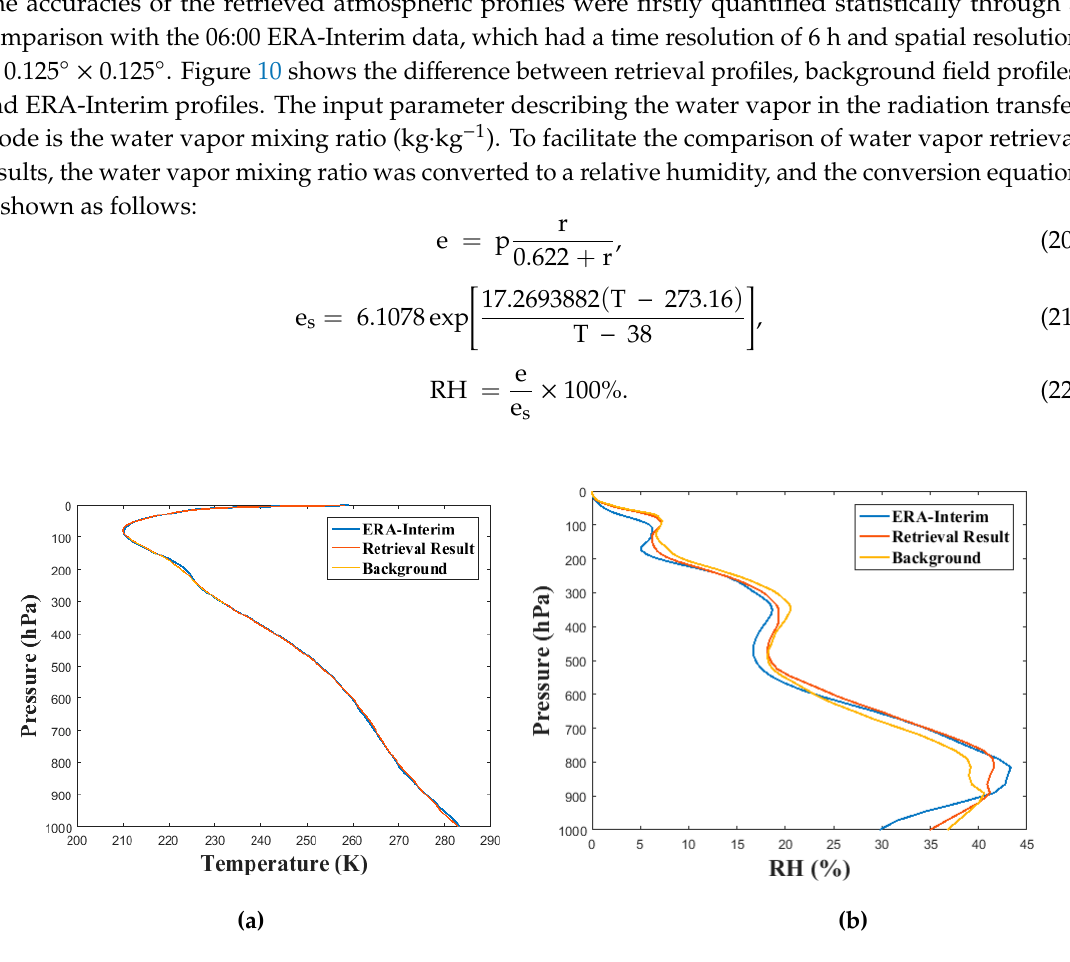
Figure 10. ( a ) Temperature and ( b ) humidity profiles based on 294 samples. The blue line represents the profile from the ERA-Interim data, the red line represents the profile through 1D-VAR, and the orange line represents the background field profile.